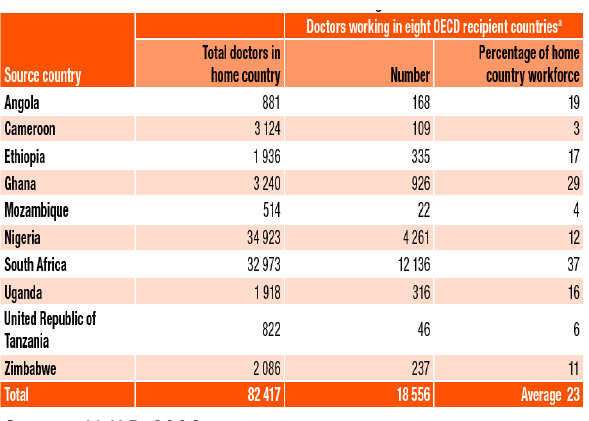
Table 4 : Doctors Trained in sub-Saharan Africa Working in OECD Countries